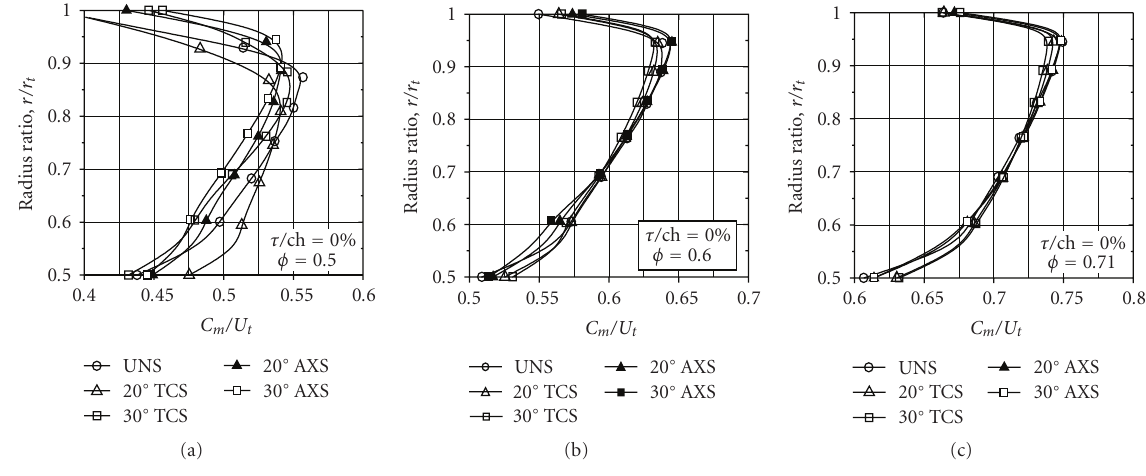
Figure 10: Spanwise variation of axial velocity coe ffi cient at the rotor